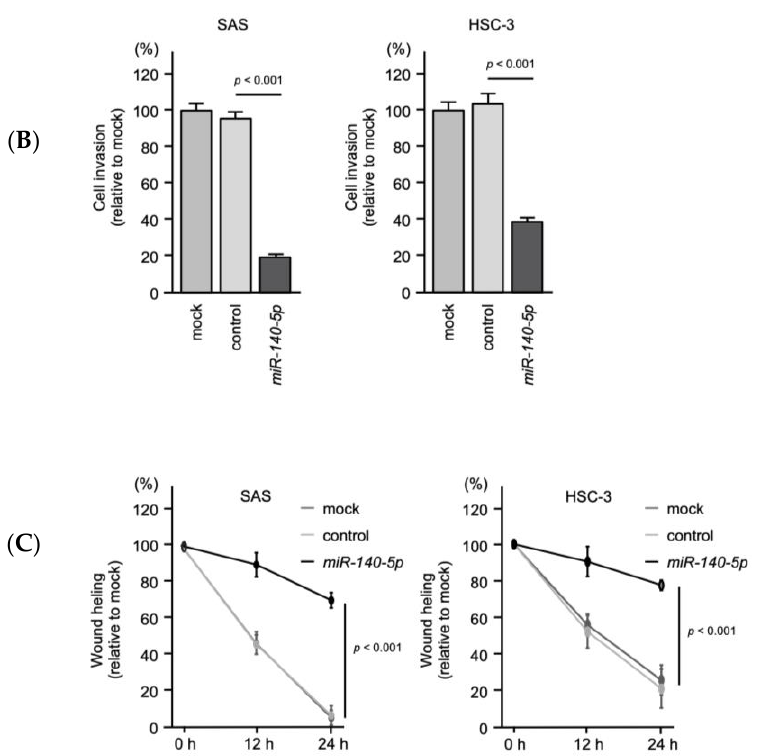
Figure 11. Tumor-suppressive function of miR-140-5p in OSCC cells. ( A ) Cell proliferation assessed with an XTT assay at 72 h after transfection of mature miRNAs. ( B ) Cell invasion determined with a Matrigel invasion assay at 48 h after seeding miRNA-transfected cells into the chambers. ( C ) Cell migration was assessed with a wound-healing assay. Data were collected 0 h, 12 h, and 24 h after cell